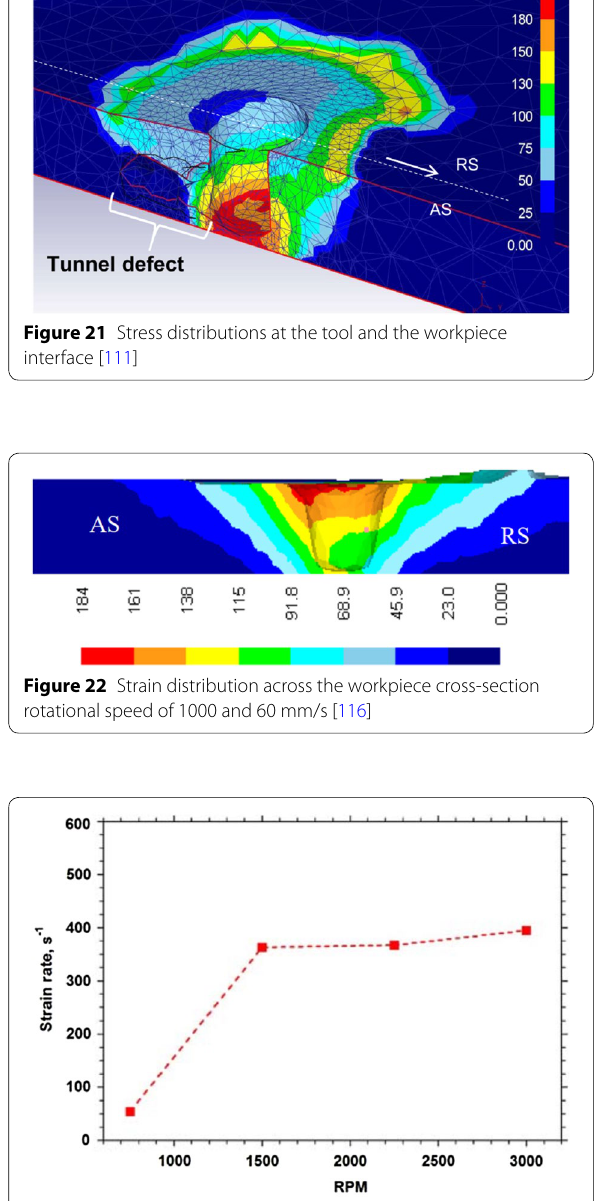
Figure 23 Relationship between the strain rate and the rotational speed